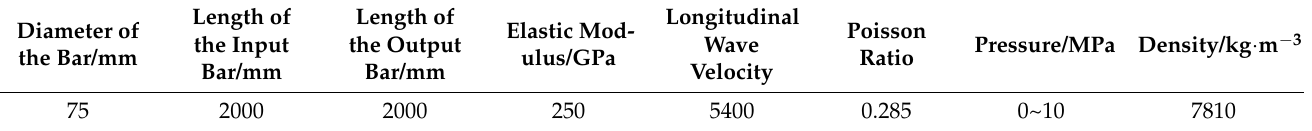
Table 1. Parameters of